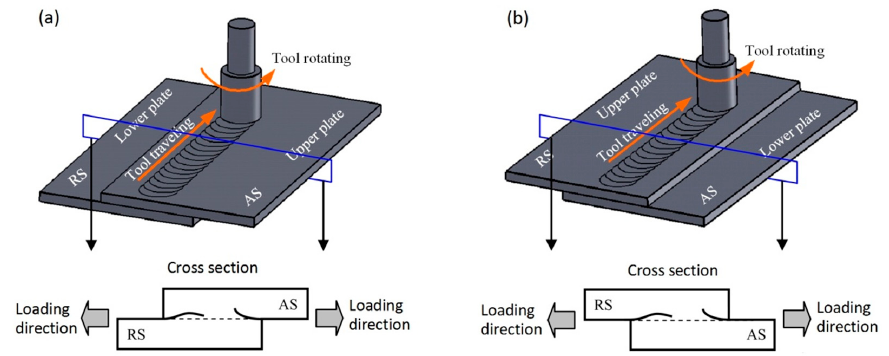
Figure 1. Different loading configurations in friction stir lap welding (FSLW): ( a ) advancing side (AS) loading; ( b ) retreating side (RS) loading [9].